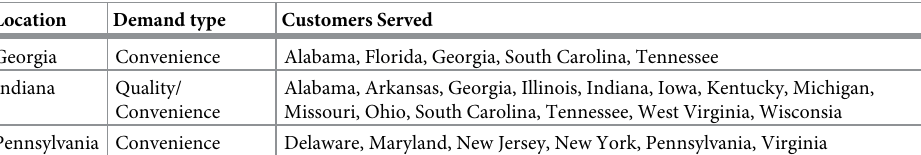
Table 5. Location scheme of the new entrant ( γ 1 = 0.9, γ 2 =